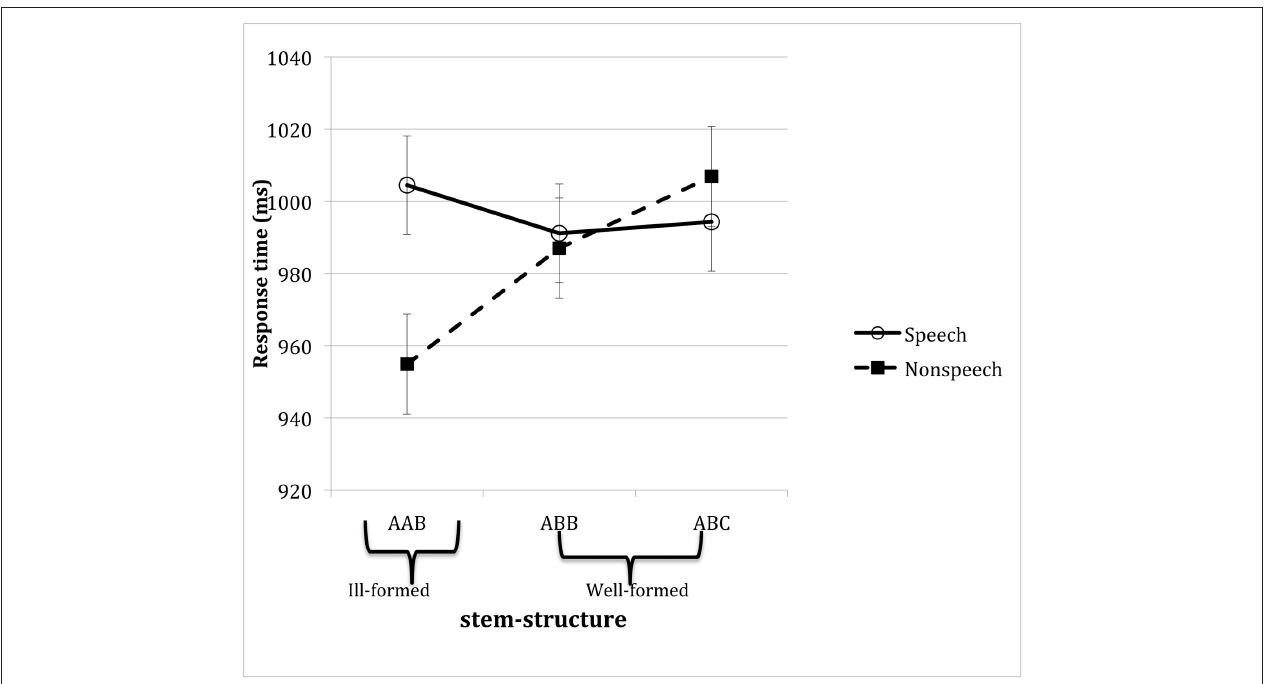
Figure 6 | Mean response time of Hebrew speakers to speech and non-speech inputs as a function of their phonological well-formedness in Hebrew. Error bars reflect confidence intervals constructed for the difference between the three types of stem structures, constructed separately for speech and non-speech stimuli.